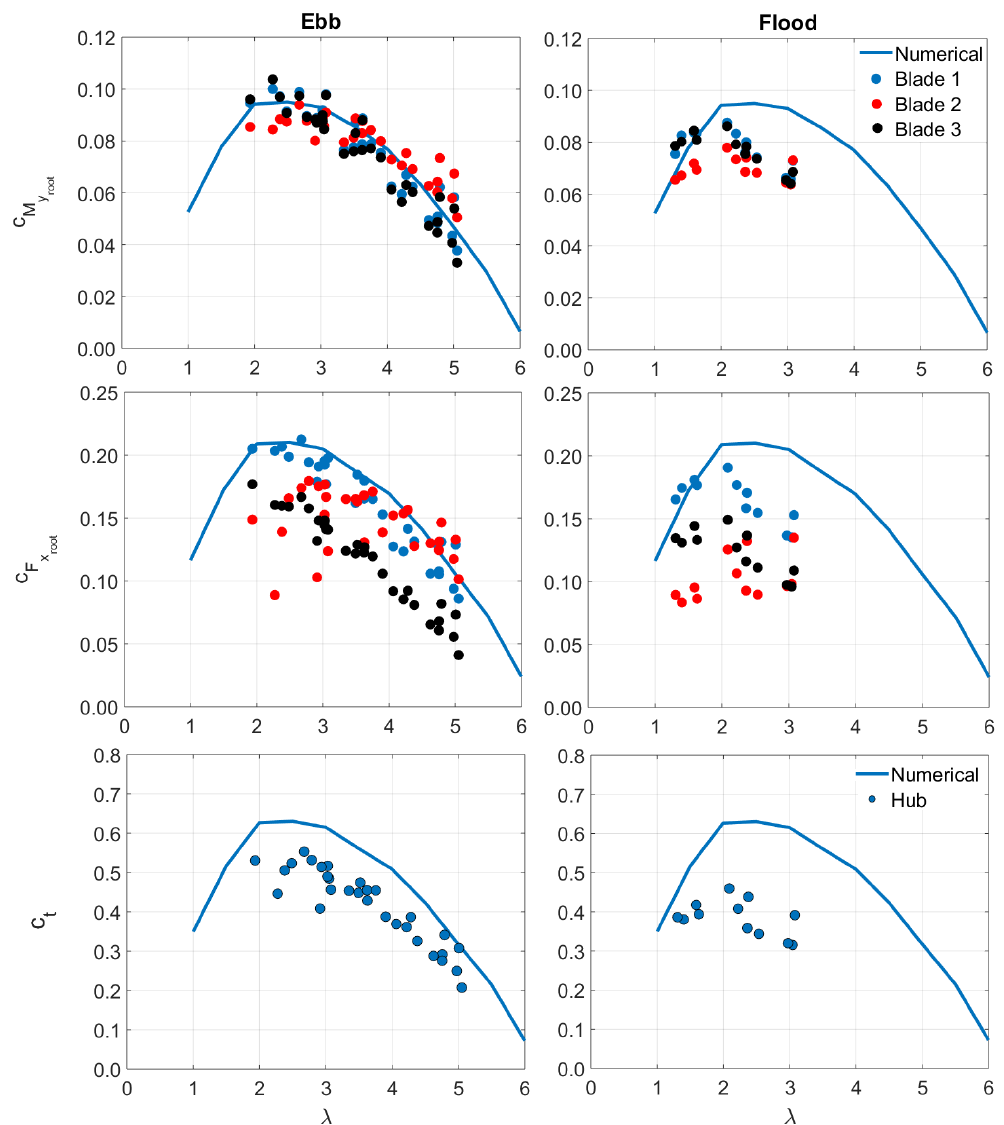
Figure 12. Measured dimensionless rotor loading curves in ebb ( left ) and flood ( right ) tides: c M ( top ); c F ( middle ); c t ( bottom y root x root